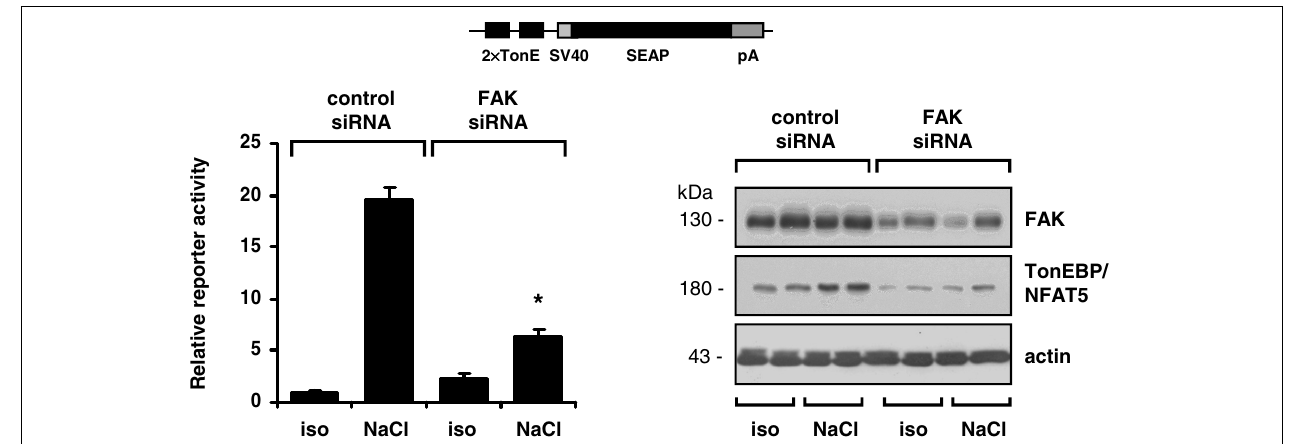
FIGURE 4 | Effect of FAK knockdown on TonEBP/NFAT5 expression and activity. HEK293-TonE cells transfected with siRNA specific for FAK or non-targeting control siRNA were incubated for 24h in isotonic (300mosm/kg H 2 O) or hypertonic medium (500mosm/kg H 2 O by NaCl addition).